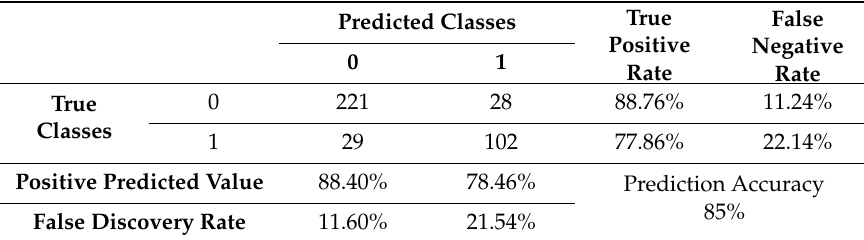
Table 1. Confusion matrix of the model with the SVO feature.